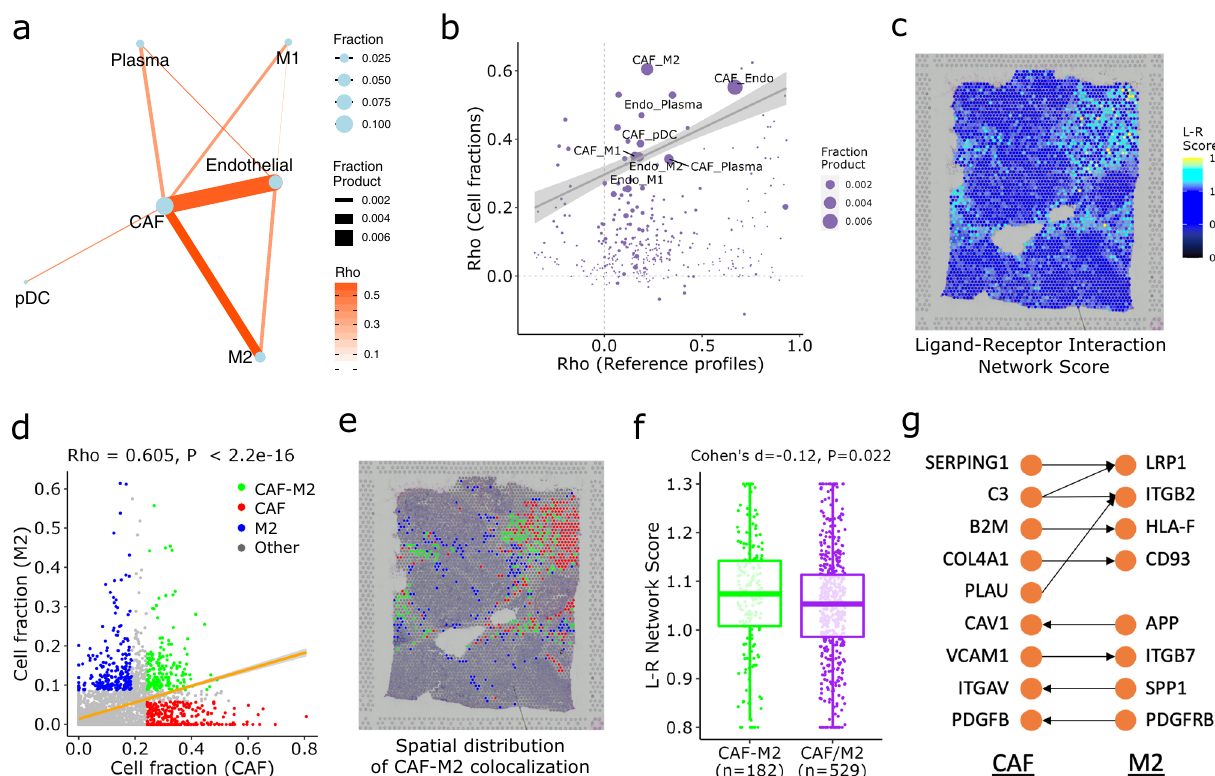
Fig. 5 | SpaCET identi fi es intercellular interactions in the breast tumor. a Spearman correlations of cell-type fractions across breast tumor ST spots. Each node in the network represents a cell type, and the size of a node refers to the average fraction of this cell type across all spots. Each edge represents the colo- calizationofacell-typepair,andthesizeofanedgereferstothefractionproductof this cell-type pair. b Spearman correlation analysis between reference pro fi les ( x - axis) and between cell-type fractions ( y -axis). Each dot represents a cell-type pair. The straight line presents the weighted linear regression result with the gray sha- dow as the 95% con fi dence interval. c Ligand – receptor interaction network scores for all spots. d CAF and M2 fractions across all spots. Each dot represents an ST spot. According to the CAF or M2 cell fractions, spots were grouped into four categories: CAF – M2 colocalized (top 15% in both CAF and M2, n =182), CAF- dominated (Top 15% in CAF and bottom 75% in M2, n =295), M2 dominated (Top